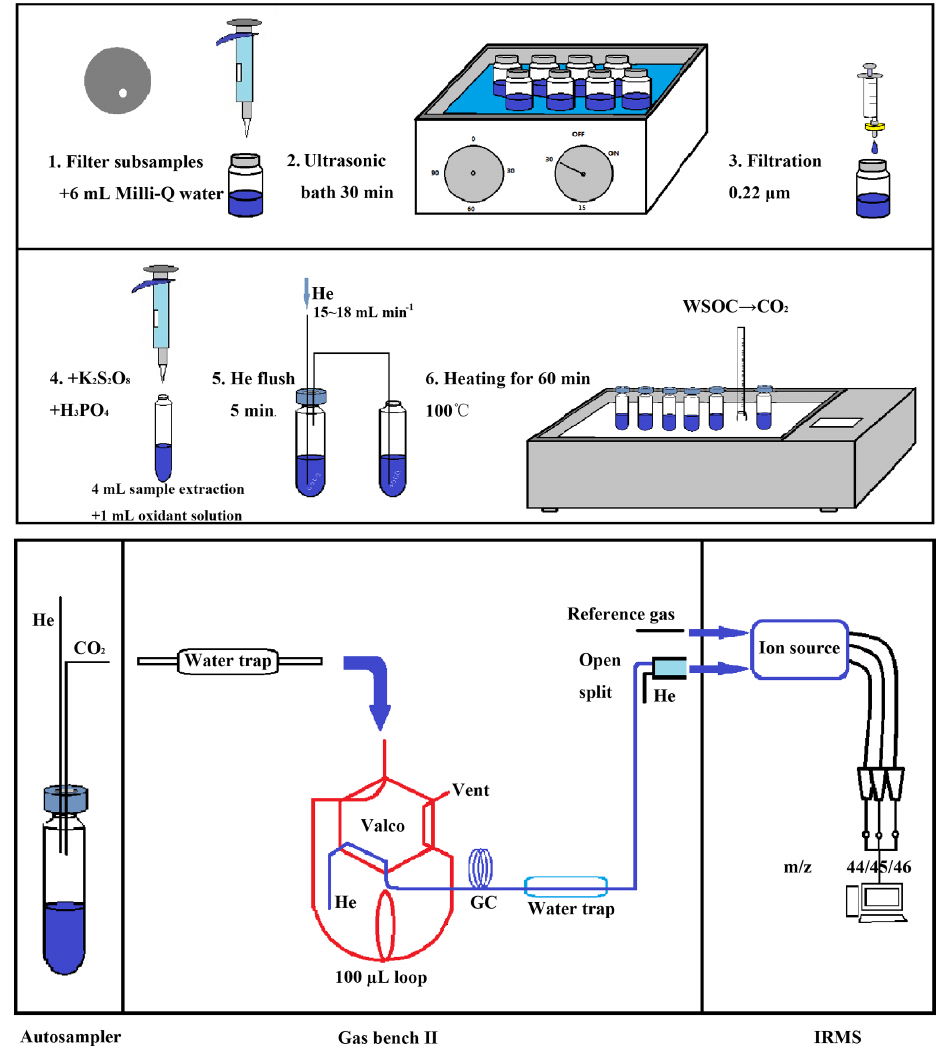
Figure 1. Schematic of the optimized method for the measurement of WSOC mass concentrations and the δ 13 C − WSOC values. A filter disk is dissolved with 6mL Milli-Q water in a 20mL pre-combusted glass bottle in the first step. After 30min ultrasonic bath, the WSOC extract is filtered with 0.22µm syringe filter and transferred to another 20mL pre-combusted glass bottle in step 3. A total of 4mL of filtrate is transferred to a 12mL pre-combusted glass vial, which contains 1mL oxidant solution (2.0g K 2 S 2 O 8 and 100µL 85% H 3 PO 4 dissolved in 50mL Milli-Q water) in the vial in step 4. Next, the mixed solution of WSOC extract and the oxidant solution is flushed with helium at a flow rate of 15–18mLmin − 1 as shown in step 5. Finally, the vials are heated for 60min under 100 ◦ C in the sand bath pot (step